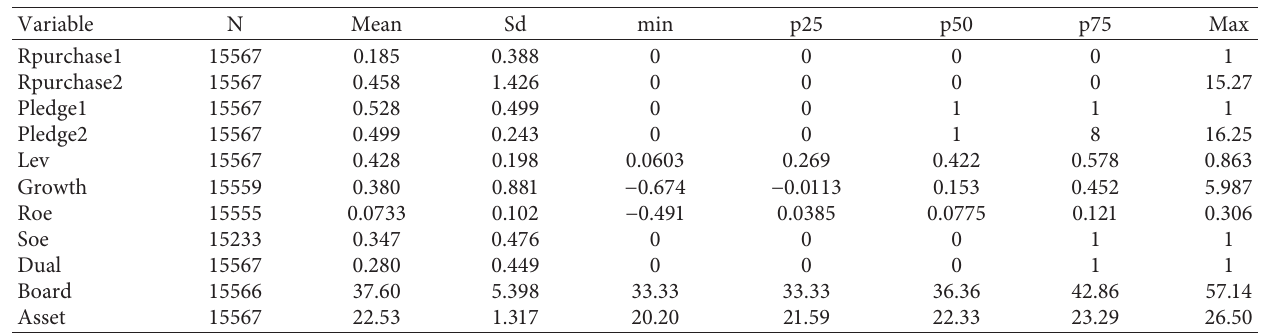
Table 2: Descriptive statistics.